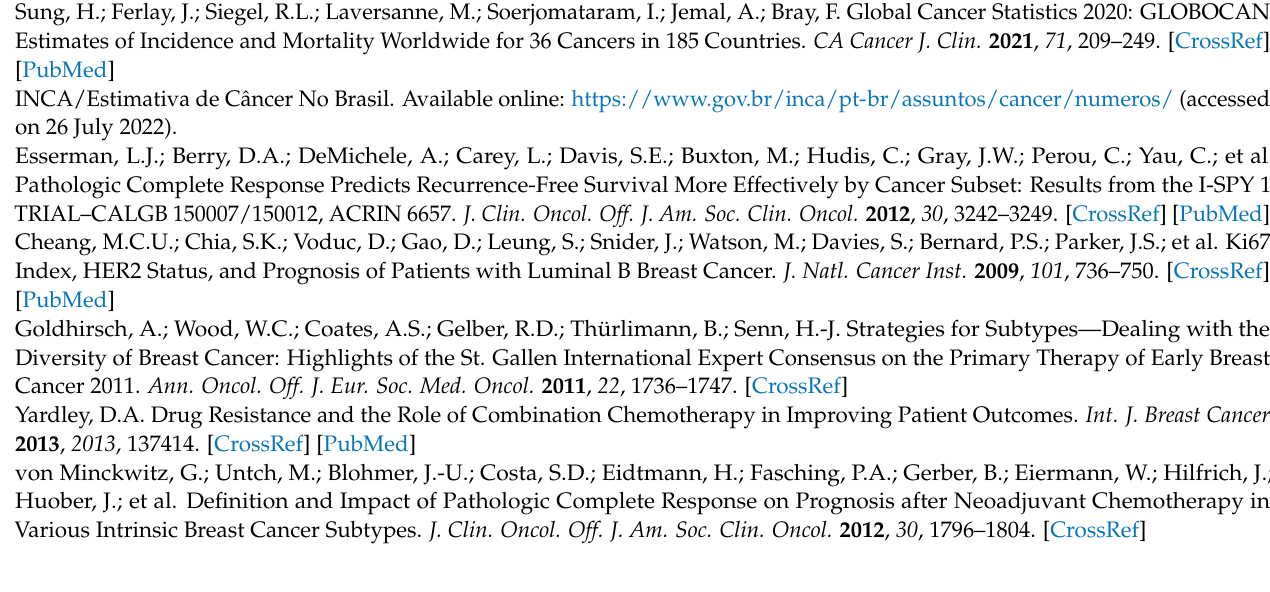
serum metabolites detected by 1H-NMR according to response to NACT. Table S6: Contribution of the HR, Ki67, HER2, and serum metabolites as predictors of the response to NACT in different models obtained with RFE + LR. Figure S1: Pathway enrichment analysis for the metabolites found as discriminatory, assuming as relevant those pathways with a p -value <